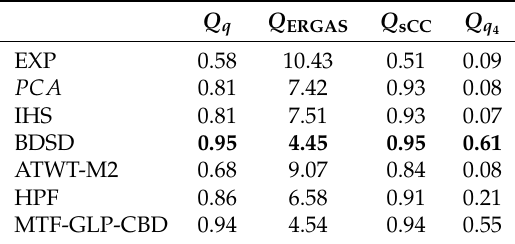
Table 7. IKONOS Roma River scene, reduced resolution quantitative results. The bold number indicates the best performing PS method according to each quality metric.